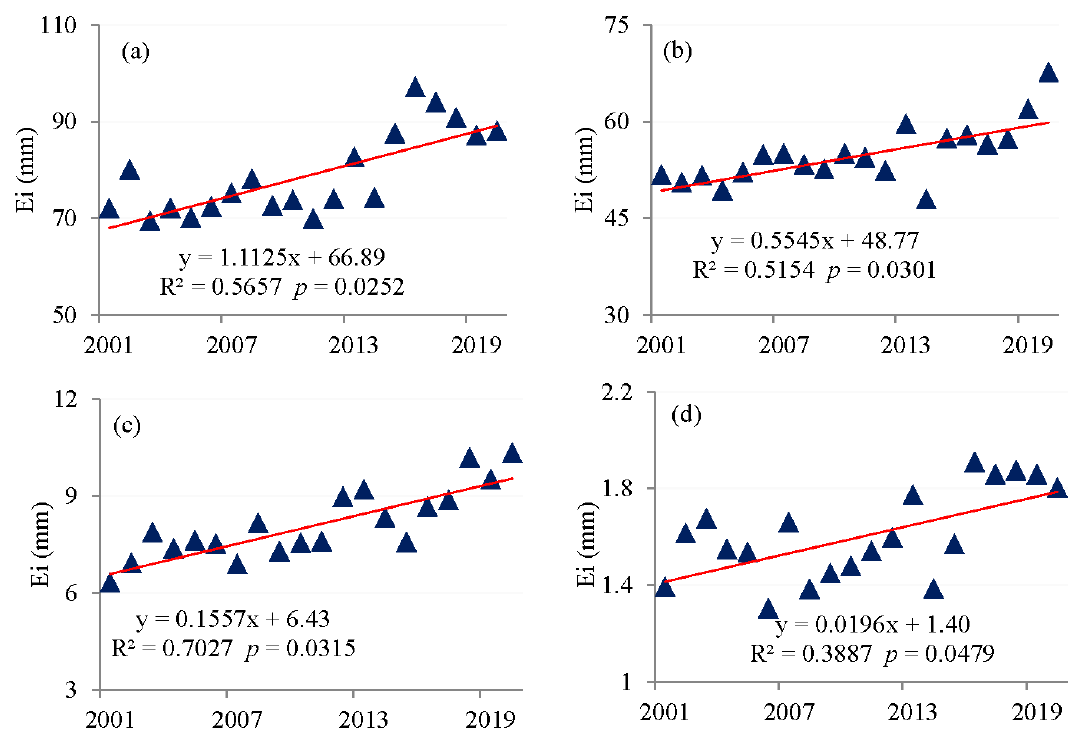
Figure 8. The temporal variation of Ei for different moisture regions during 2001 − 2020. ( a ) Humid region; ( b ) semi-humid region; ( c ) semi-arid region; ( d ) arid